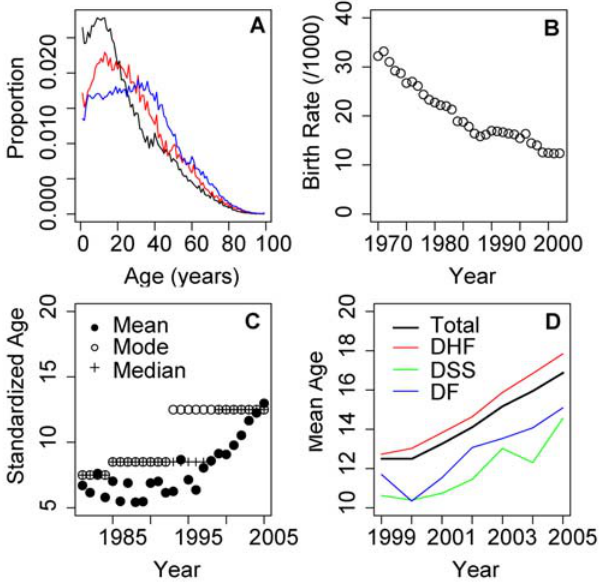
Figure 1. Demographic changes in Thailand and changes in the age distribution of dengue illness. (A) Age structure of the Thai population 1980 (black), 1990 (red), and 2000 (blue). (B) Birth rates per 1,000 individuals 1970–2000. (C) Mean, median, and modal age of age- standardized dengue incidence data in Thailand 1981–2005. Age- specific incidence in all years was standardized to age distribution of Thailand’s population in 2000 using direct age adjustment. Mean (filled circles), mode (unfilled circles), and median (plus sign) age of standardized age-specific incidence of dengue disease reported to the national surveillance system for each year are shown. (D) Mean age of DHF (red), DSS (green), DF cases (blue), and total (black) cases reported to the national surveillance system 1999–2005.